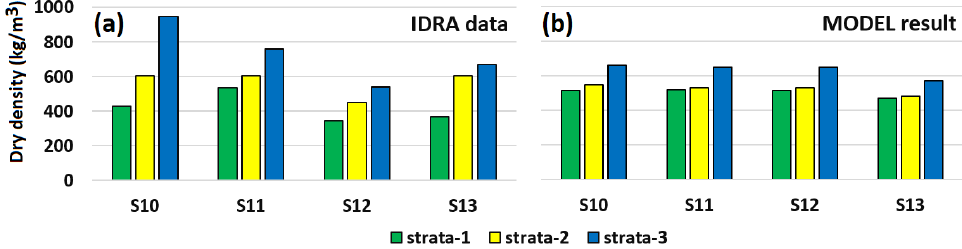
Figure 6. Sediment dry densities (kg/m 3 ) at stations S10–S13 of the 3 strata, on 28 July 2009: ( a ) [2] measurements; ( b ) model scenario